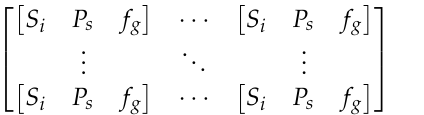
(cid:3) f g represents the information contained in a grid, S i is the